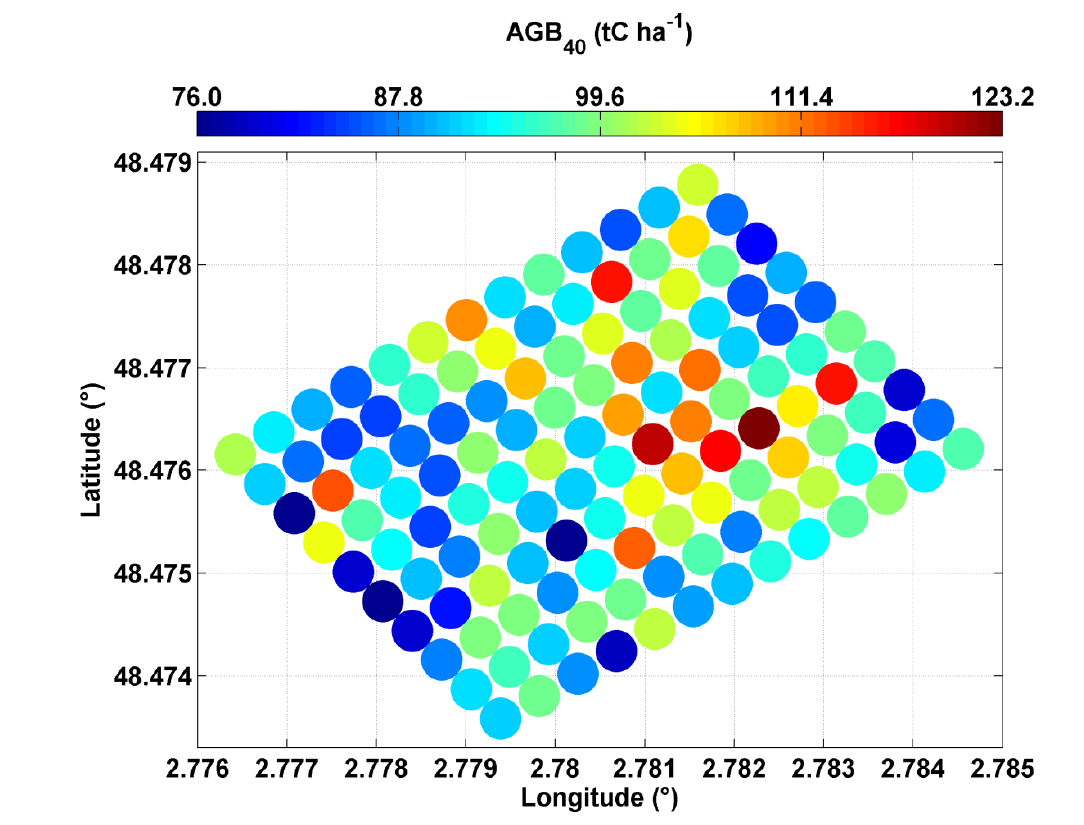
Figure 10. Lidar-derived plot-level aboveground carbon for 40 m × 40 m forest plots ( AGC ) at Site 40